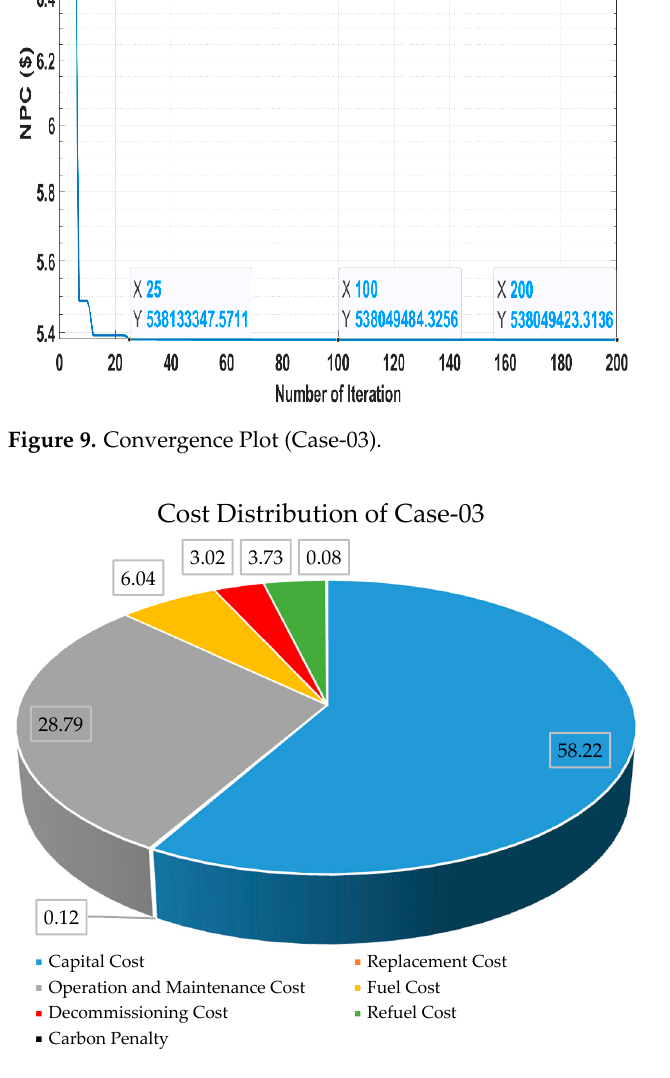
Figure 10. Cost Distribution (Case-03).